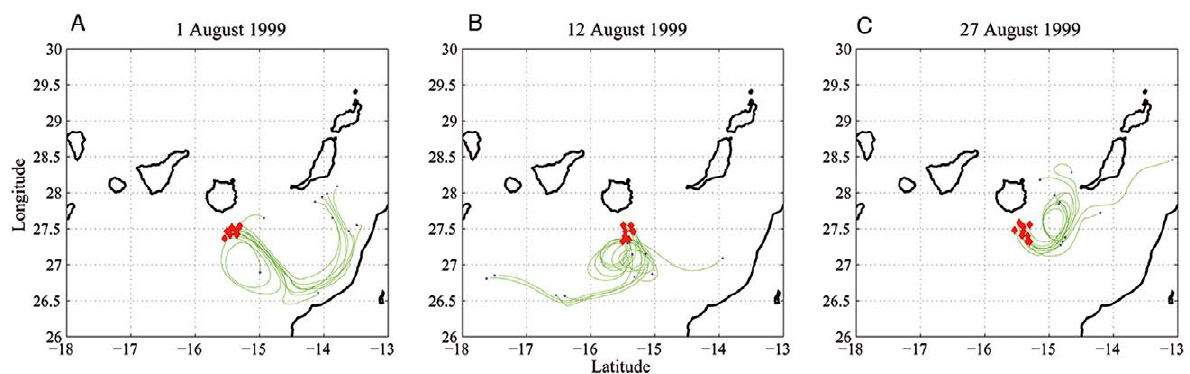
Fig. 9. – Example of backtracking trajectories of larvae sampled area south of Gran Canaria (red dots) on 1 August (A), 12 August (B) and 27 August 1999 (C). The green lines show the simulated pathways followed by the larvae during the 15 days before they reach the sampling area (red dots) according to the hydrodynamical